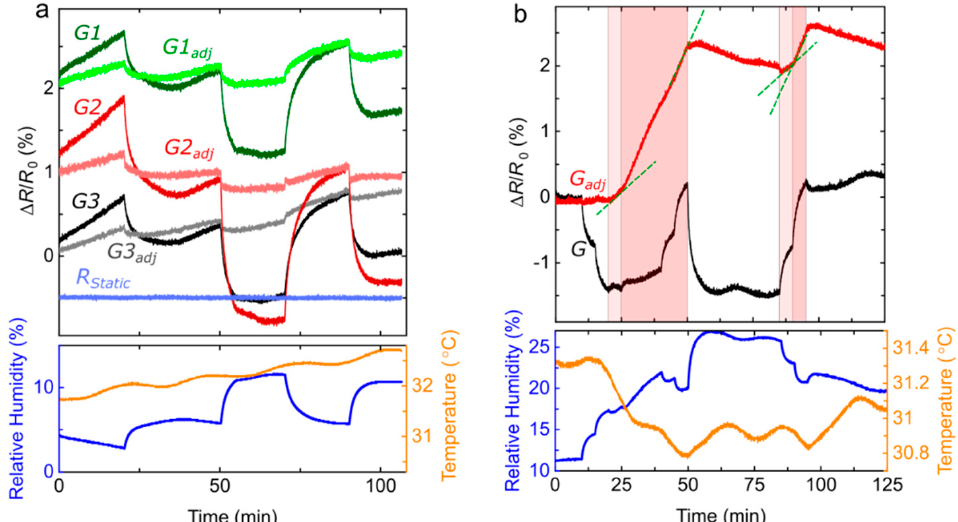
Figure 5. ( a ) The sensing platform inside an enclosure allows us to remotely monitor the signal ( Δ R / R 0 ) of three graphene sensors, G1 , G2 , and G3 , one static resistance R Static (top panel, with a vertical offset of 1% between all readings), as well as the relative humidity and temperature provided by the TH sensor (bottom panel). As we introduce varying concentrations of water vapour inside the enclosure a correlation is observed between the G ’s and the humidity. We use Equation (1) to adjust the graphene sensors’ response to a signal , G adj , more independent to fluctuations in humidity and temperature. ( b ) The experiment is repeated with one graphene sensor while introducing different concentrations of ethanol vapour (red regions) and water vapour (not indicated with background color but traceable from the relative humidity readings). The light red region corresponds to an ethanol vapour concentration of 7800 ppm and the darker red region to a higher concentration of 13,700 ppm.